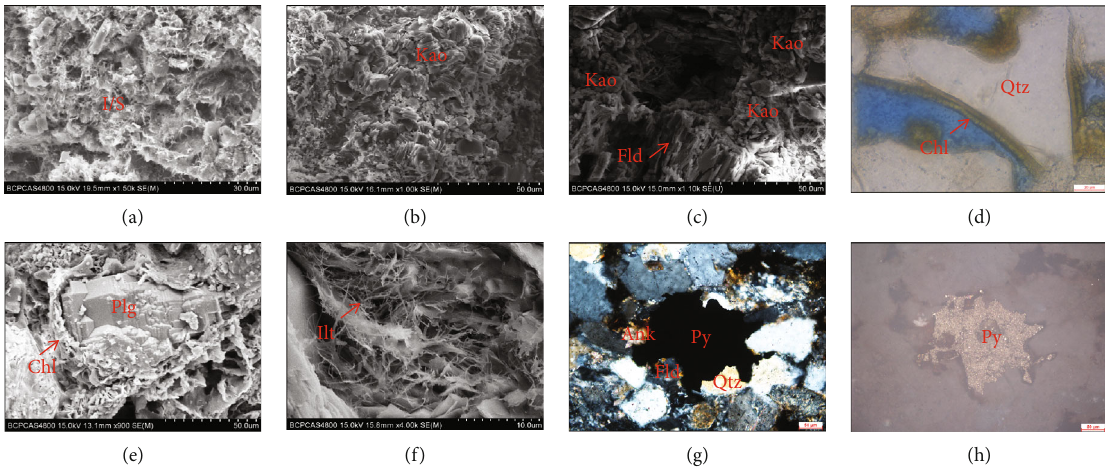
Figure 7: Diagenetic characteristics of the deeply buried Es sandstones in Raoyang Sag. (a) Well LG3: 3824.3m, I/S taking place as the forms 3 of foliage and/or honeycomb, SEM. (b) Well L425: 3662.6m, modi fi ed kaolinite to some extent attaching to grain surfaces, SEM. (c) Well N62: 3565.5m, kaolinite aggregates developing in pores near dissolved feldspars, SEM. (d, e) Well N35: 3758.7 m, chlorite coating growing around framework grains, PPL and SEM. (f) Well L101: 3804.2m, illite acting as fi brous crystals with long axis perpendicular to grain surfaces, XPL. (g, h) Well N35: 3758.72m, pyrite engul fi ng and replacing quartz, feldspar, and ankerite, XPL and RL. I/S: illite/smectite; Kao: kaolinite; Plg: plagioclase; Fld: feldspar; Chl: chlorite; Py: pyrite; Qtz: quartz; Ilt: illite; RL: re fl ected light.